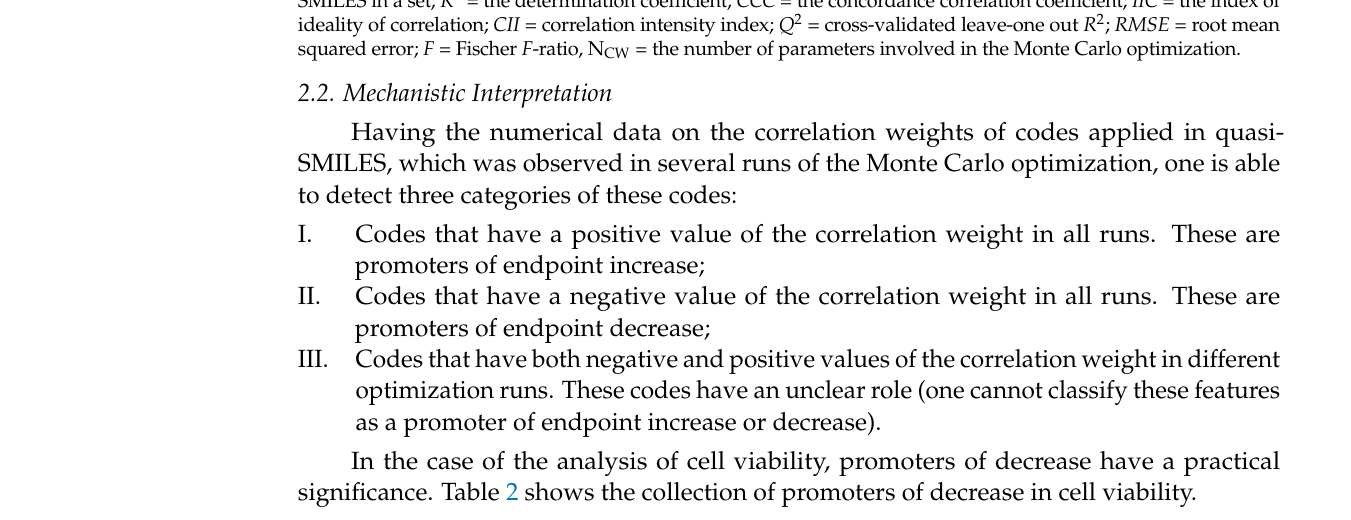
Table 2. Promoters ( ↓ ) of decreased cell viability in THP-1 cells, according to computational experi- ments with five random